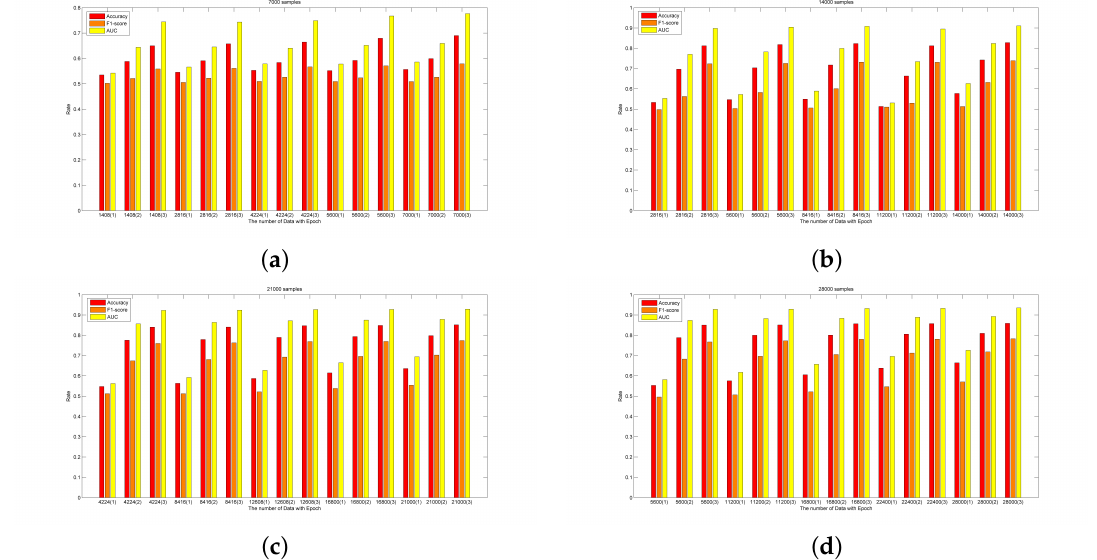
Figure 7. Results of the model when Epoch = 3 (English dataset). ( a ) data samples = 7000. ( b ) data samples = 14,000. ( c ) data samples = 21,000. ( d ) data samples = 28,000.